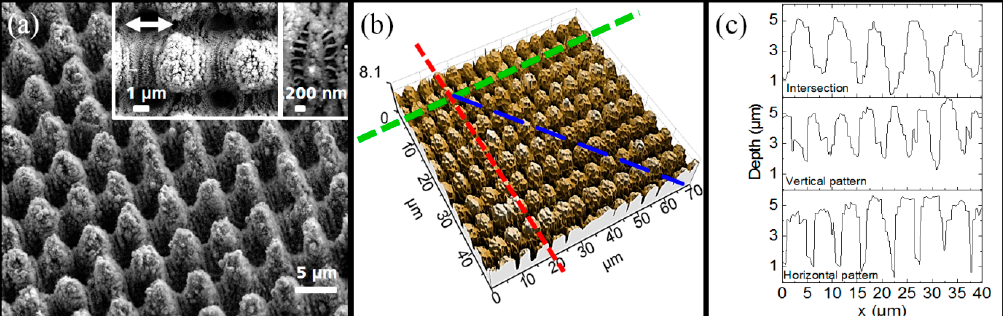
Figure 2. ( a ) Scanning electron micrograph (tilted at angles of 20° in x and 10° in y ), the arrow denotes the beam polarization correlated with the irradiation after rotating the substrate 90°; ( b ) confocal microscopy image of DLIP pillar-like structure on stainless steel with a spatial period Λ of 5.5 µm, produced with a laser fluence of 0.74 J/cm 2 and 99% overlap. The lines in ( b ) denote the profiles from where the depth of the pillars was measured (green horizontal, red: vertical, and blue: intersection depths); ( c ) profiles obtained by confocal microscopy.